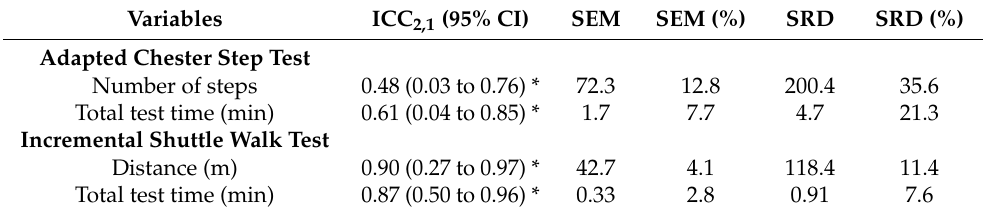
Table 4. Results of reliability measures of the adapted Chester step test and incremental shuttle walk